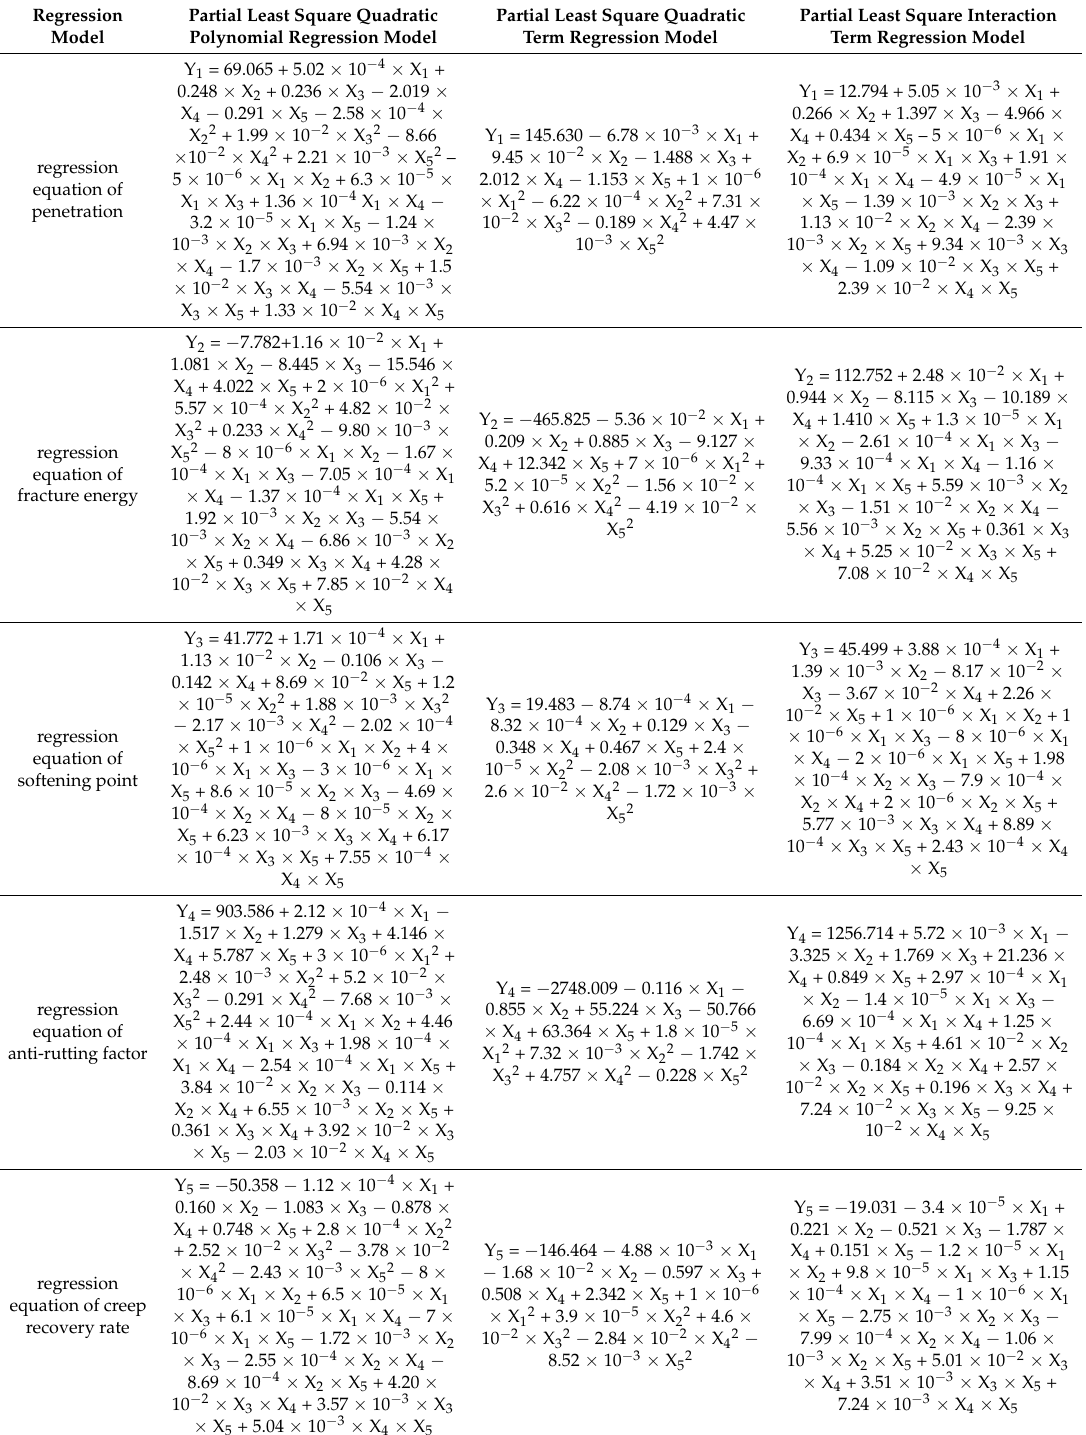
Table 7. Equation data of regression fitting